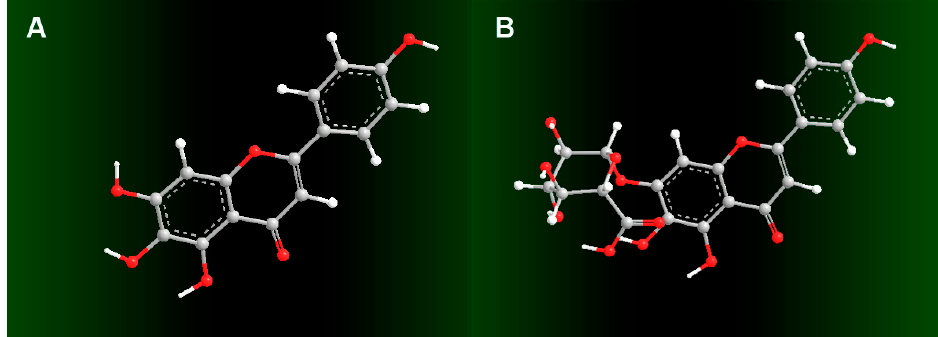
Figure 5. Preferred conformational ball-and-stick models of scutellarein ( A ) and scutellarin ( B ). The ball-and-stick models were created using Chem3D Pro 14.0.